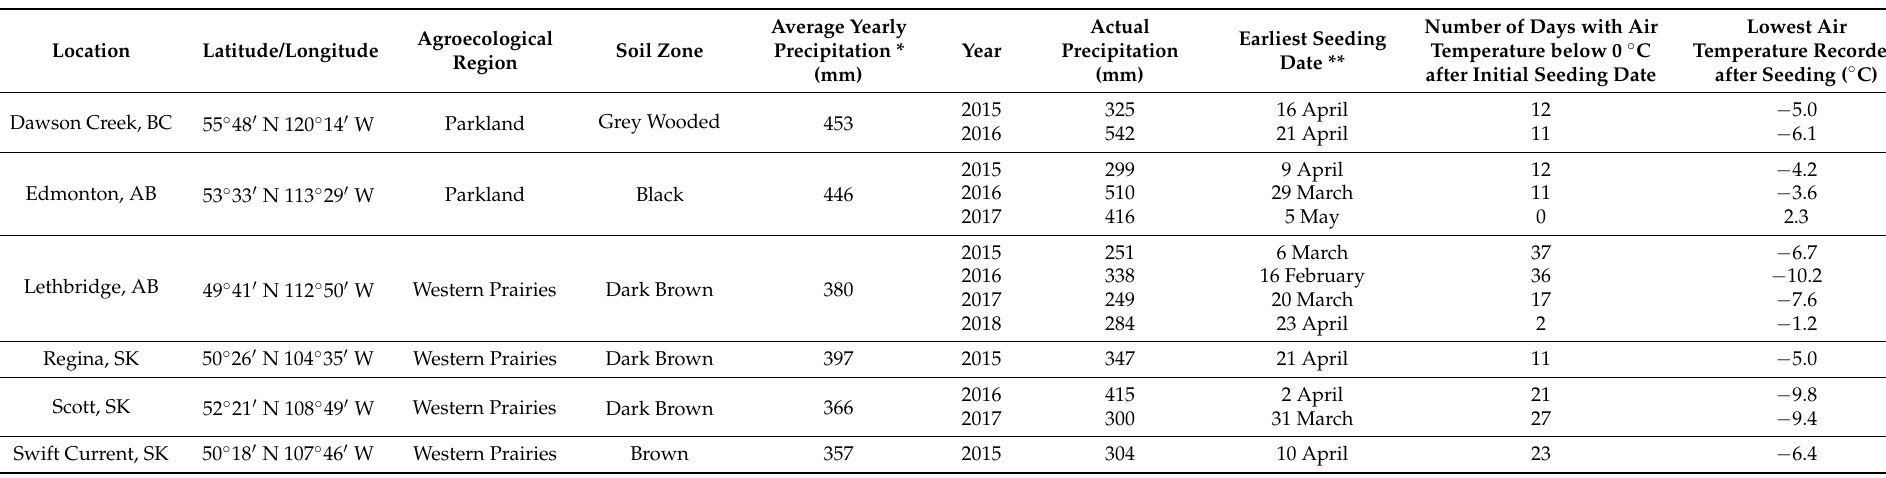
Lowest Air Temperature Recorded after Seeding ( ◦